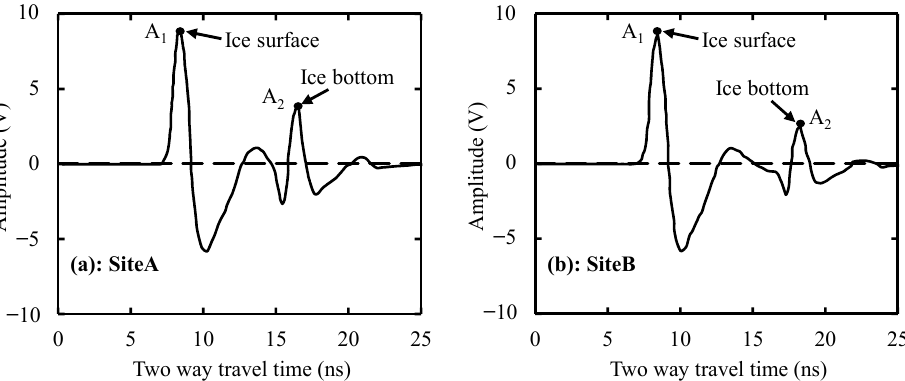
Figure 4. The standard time-voltage wiggle traces of the GPR signal at Site A ( a ) and Site B ( b ) that measured on 15 February 2014.